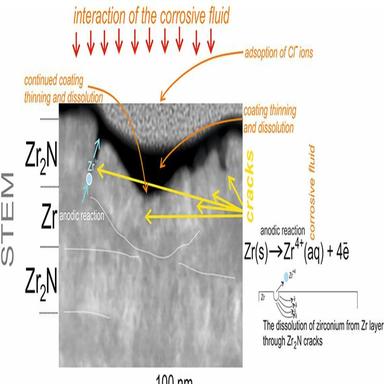
Anodic dissolution mechanism of the Zr/Zr2N (1:1 ratio) multilayer coating determined by using the STEM image.